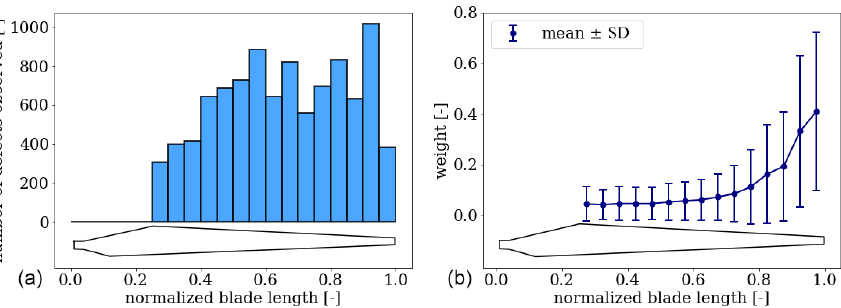
Figure 7. (a) The total number of defects observed per cross-section of the blade and (b) the corresponding defect weights (mean and standard deviation).